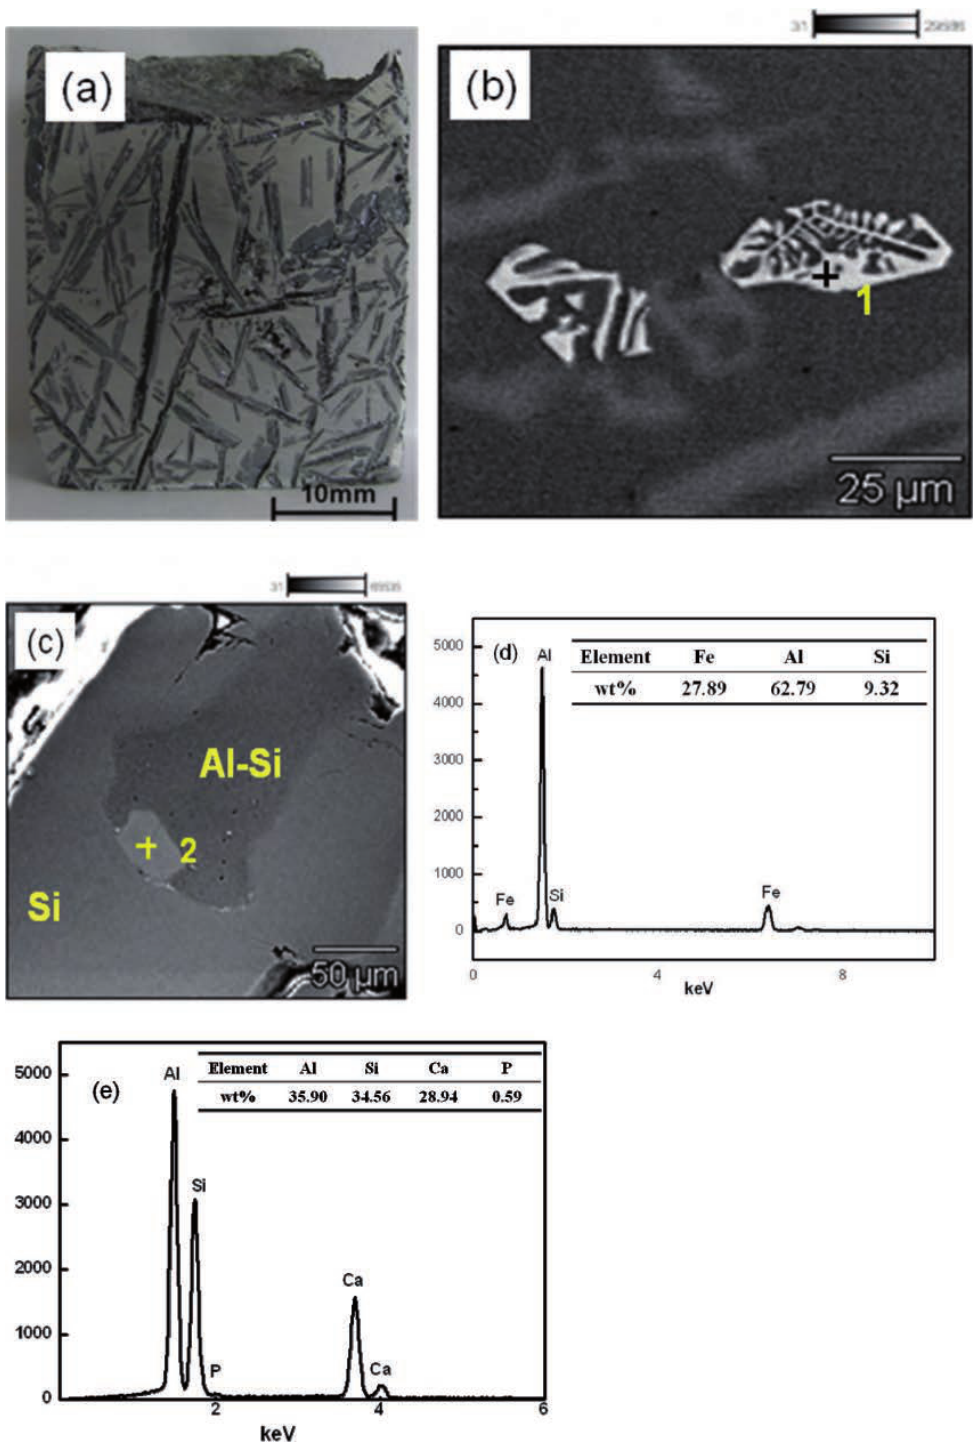
Fig. 6: (a) Macrostructure of Al-45%Si alloy; (b) and (c) SEM images of impurities in Al-45%Si alloy; (d) EDS result of point 1 in (b); (e) EDS result corresponding to point 2 in